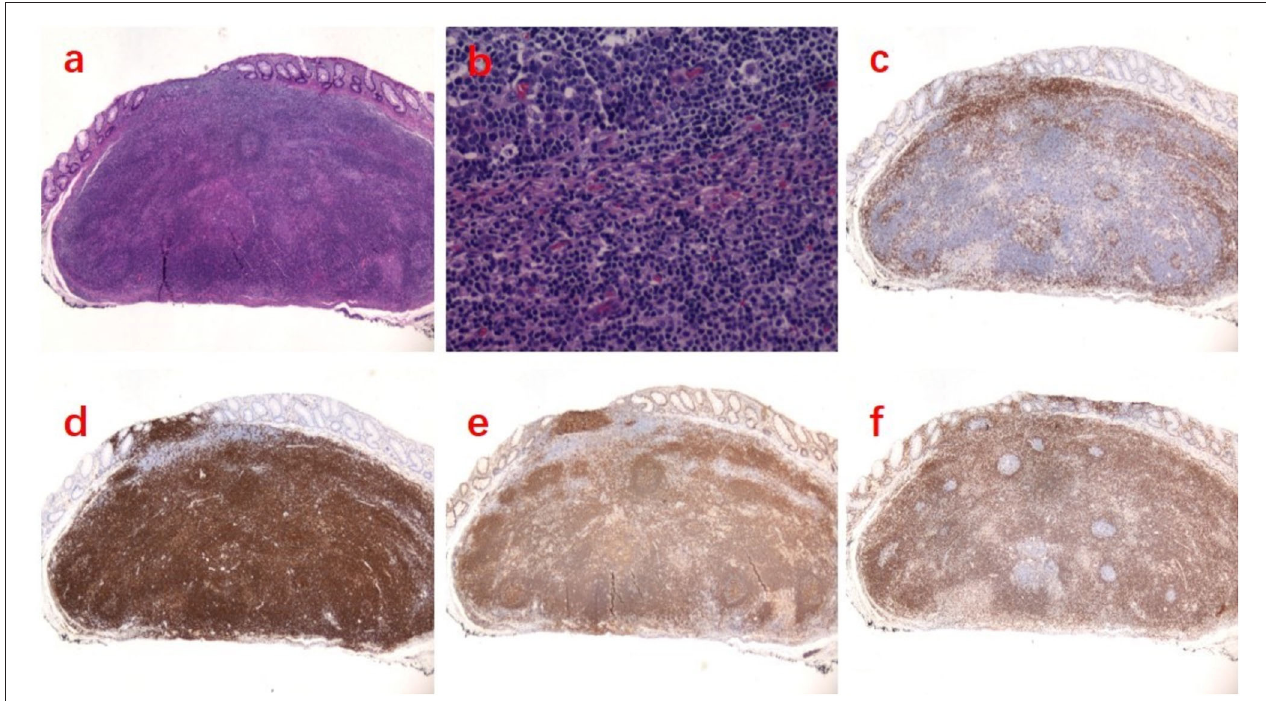
FIGURE 2 | Histopathologic examination revealed a MALT lymphoma of the rectum. (a) Hematoxylin-eosin (HE) staining × 20. (b) HE staining × 200. (c) Immunohistochemistry (IHC) was negative for CD3. (d) IHC was positive for CD20. (e) IHC was positive for CD21. (f) IHC was positive for Bcl-2.